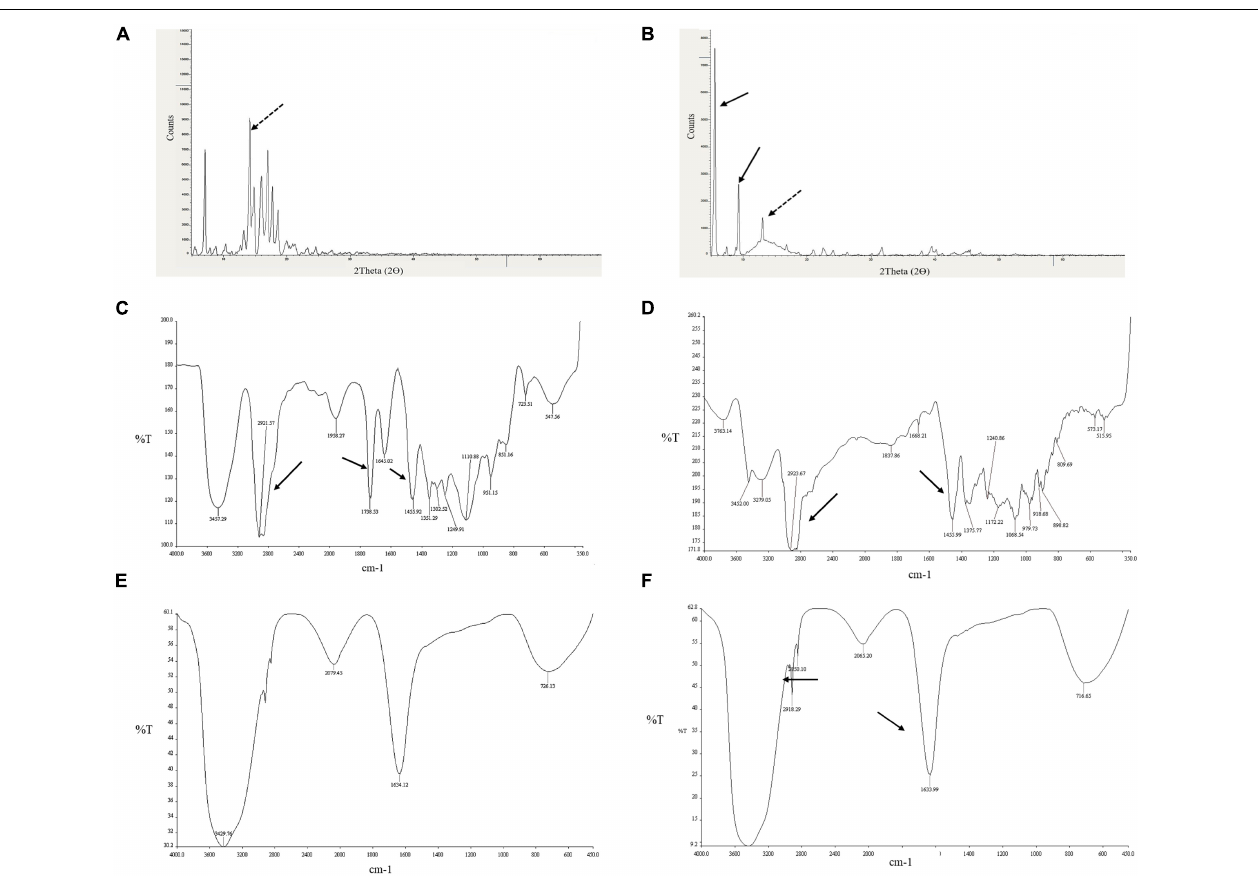
FIGURE 4 | Depiction of diosgenin functional groups with XRD and FTIR patterns. (A) XRD peaks for diosgenin. (B) Shows peaks for diosgenin that is incorporated in solid lipid nanoparticles. Dotted black arrow indicates diosgenin peak; solid black arrow, solid lipid nanoparticles. FTIR spectrum showing (C) Tween 80 peaks, (D) diosgenin peaks, (E) blank solid lipid nanoparticle peaks, and (F) Tween 80 coated diosgenin solid lipid nanoparticle peaks. Arrows indicate characteristic